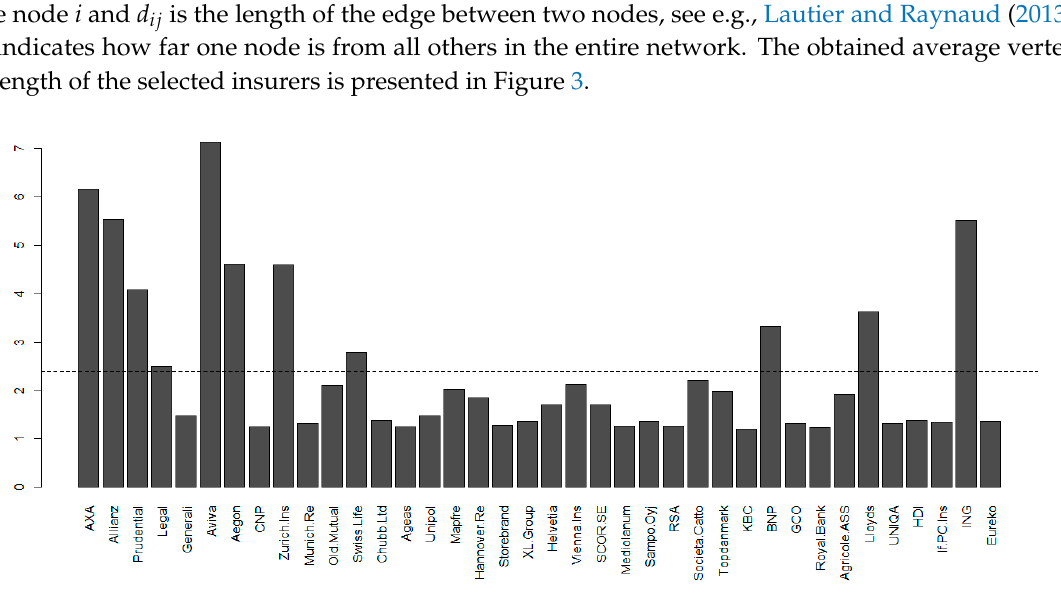
Figure 3. Average insurers strength in the period under consideration. Source: Own study.